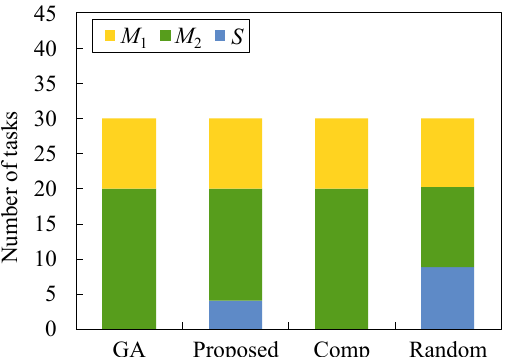
Figure 8. Number of tasks allocated to each server in the case of N 1 = 30, τ = 0.2, and λ = 2.0.